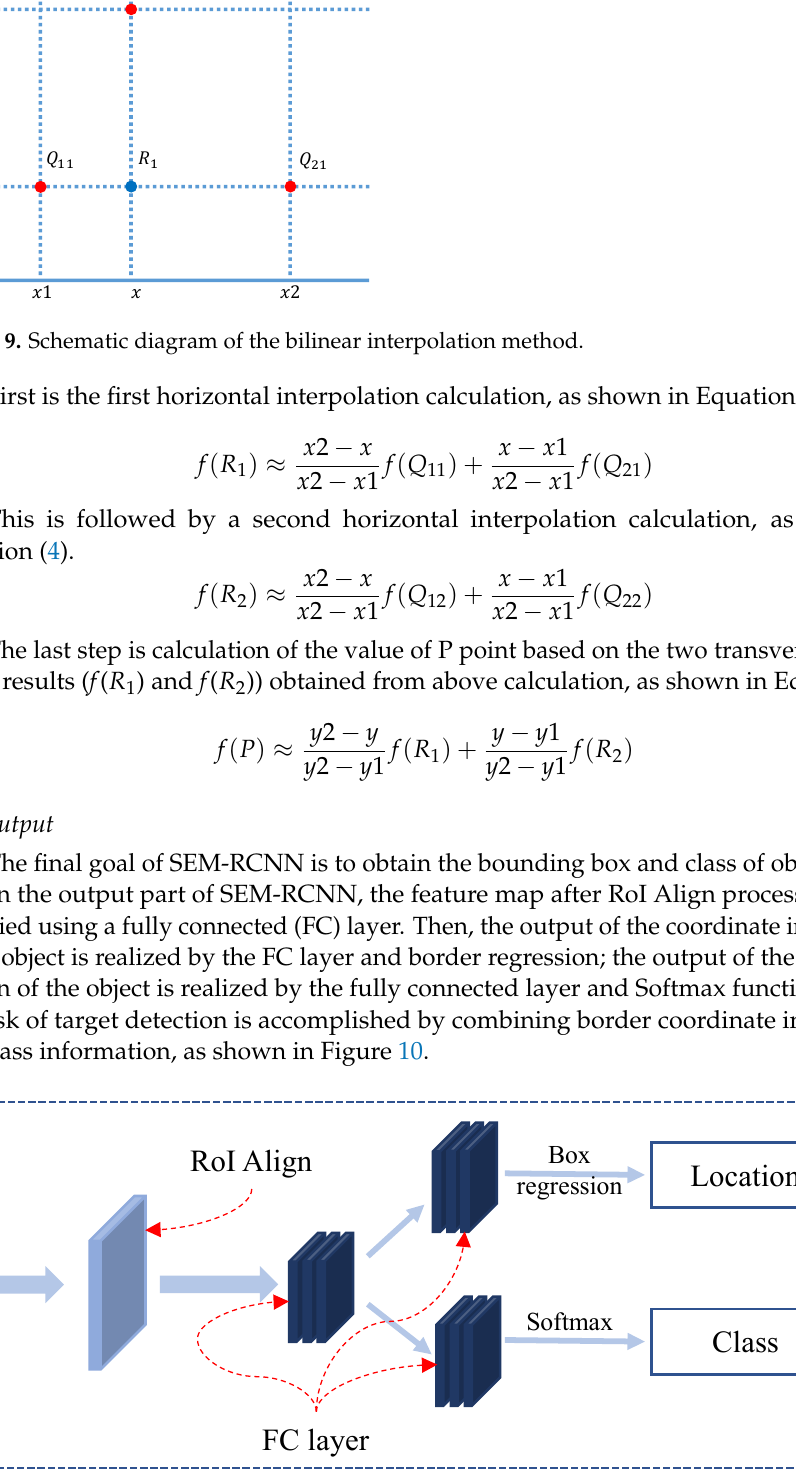
Figure 10. The output part of